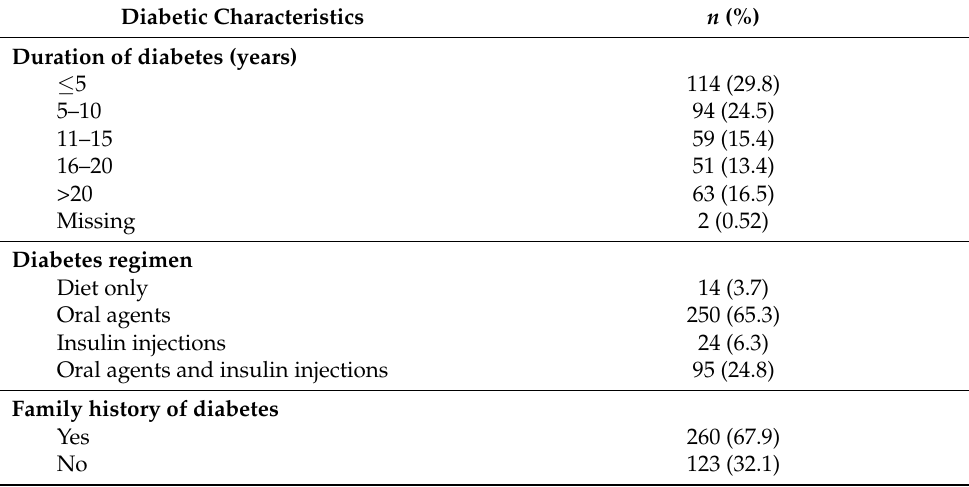
Table 2. Diabetes-related characteristics of the study participants ( n =